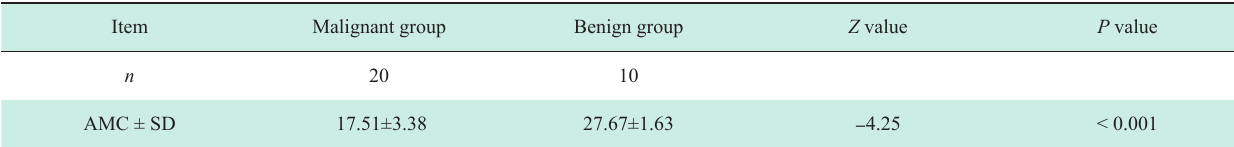
Table 3 The comparison of MVD counts between benign and malignant thyroid nodules (Mean ± SD)